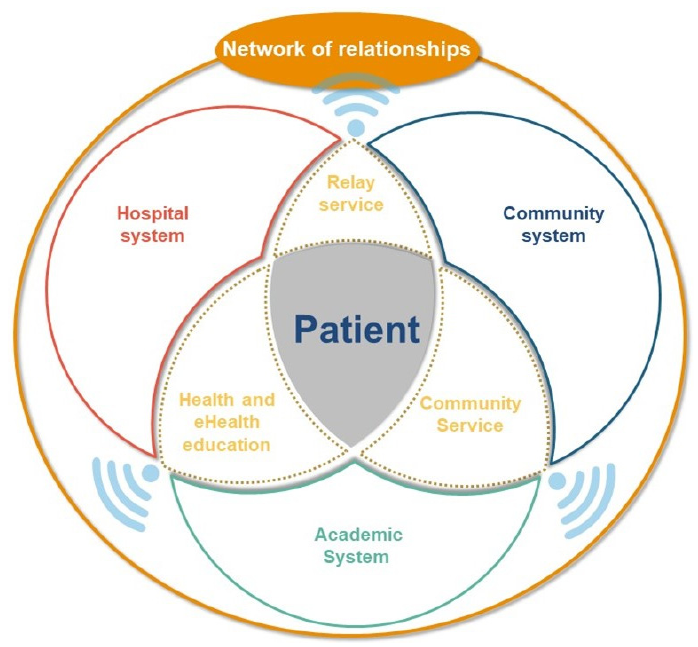
Figure 2. Network of